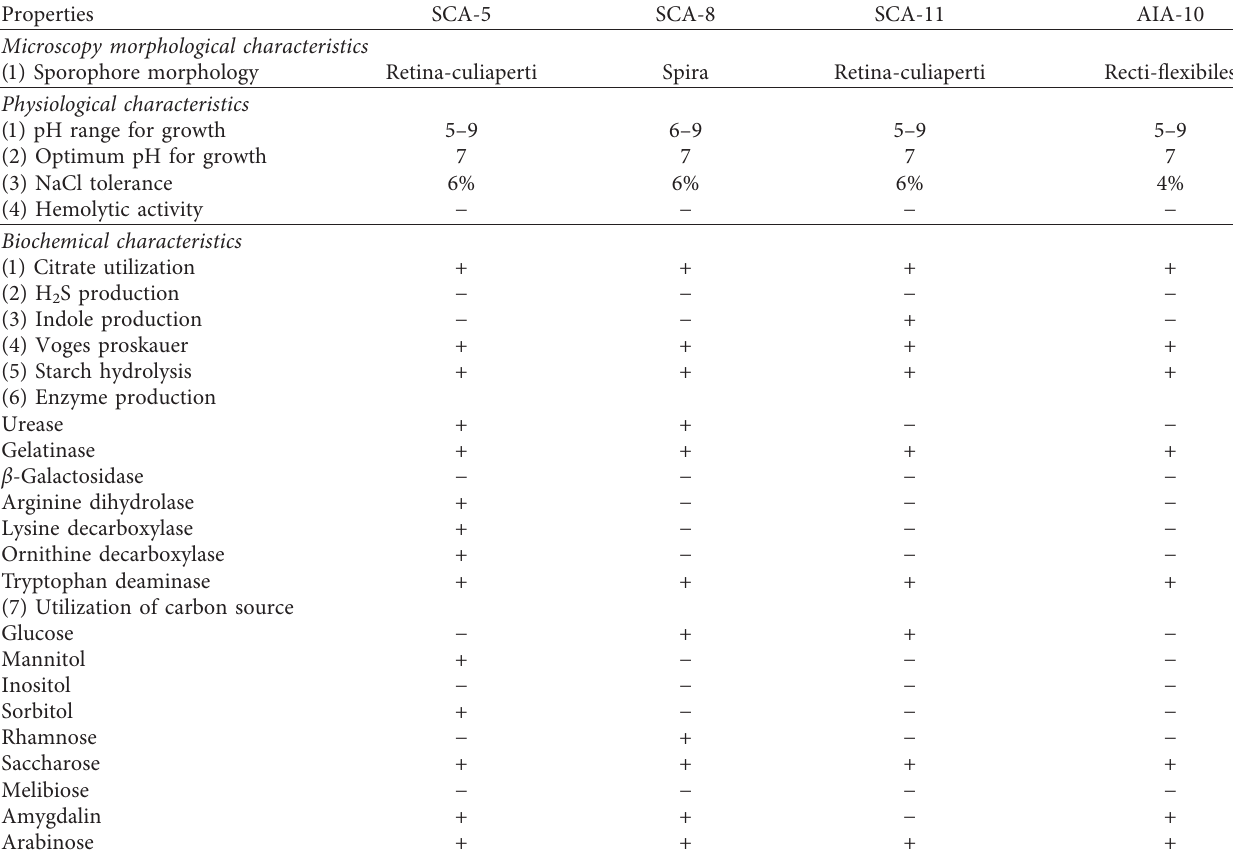
Table 4: Microscopy morphological, physiological, and biochemical characteristics of selected Streptomyces isolates.